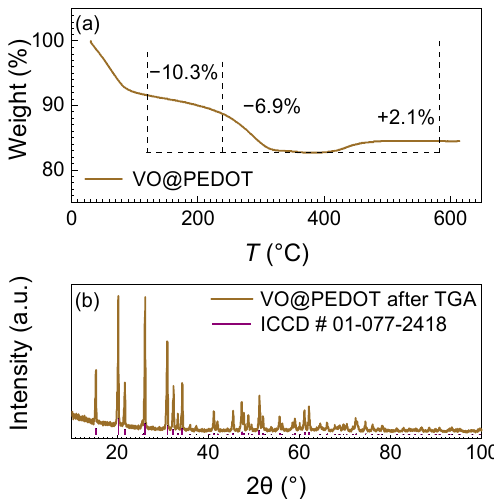
Figure 3. ( a ) TGA curve for VO@PEDOT and ( b ) its XRD pattern after TGA.